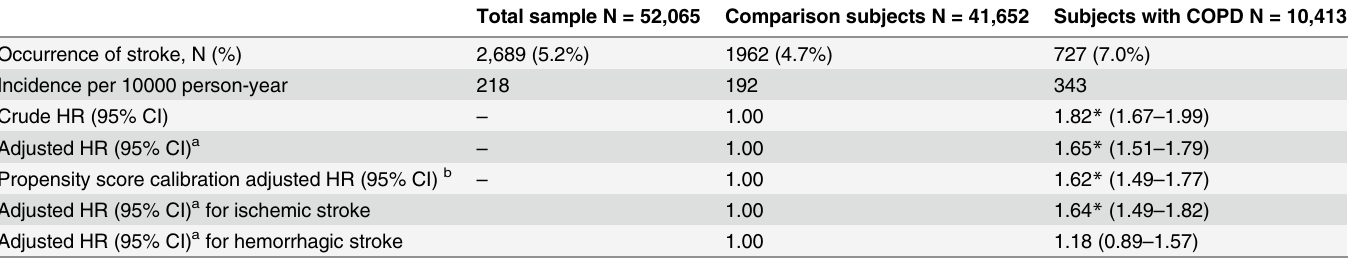
Table 2. The Crude and Adjusted Hazard Ratios for Stroke among the Sample Subjects during the Three-year Follow-up Period Starting from the Index Ambulatory Care Visits (N = 52,065).